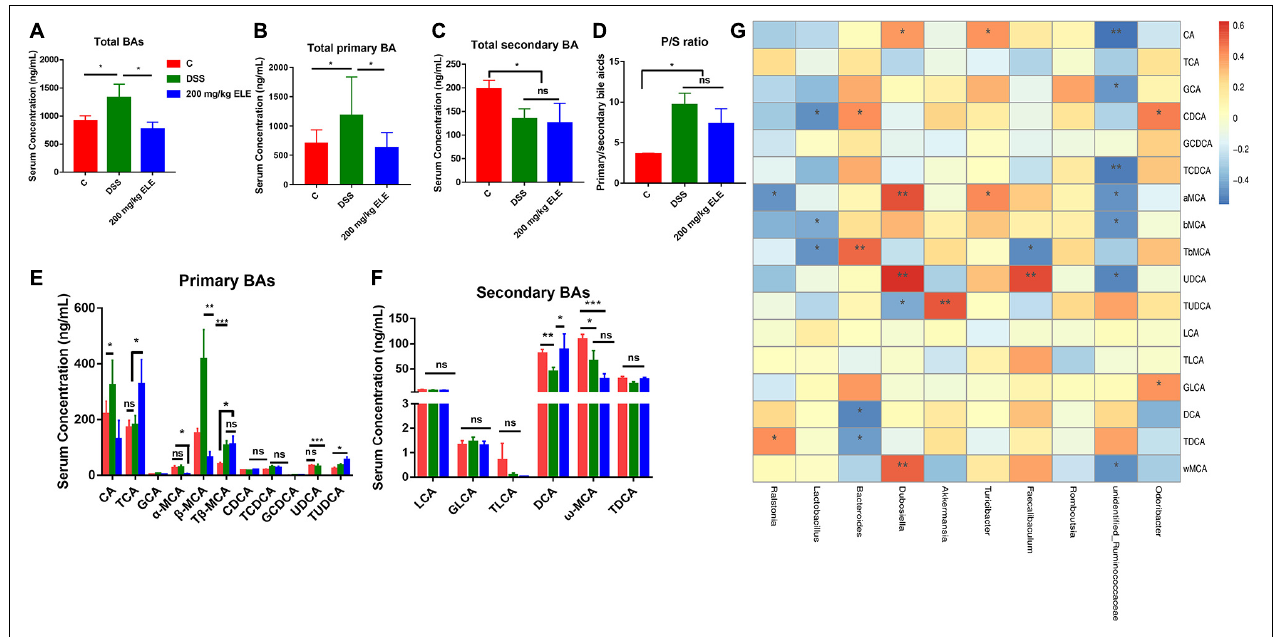
FIGURE 4 | Oral administration of ELE regulated the bile acids through gut microbiota regulatory effect in mice. (A) Content of total BA in serum. (B) The content of total primary BA in serum. (C) Content of total secondary BA in serum. (D) Ratio of primary bile acid to secondary bile acid content in serum. (E) Qualitative and quantitative analysis of primary bile acids. (F) Qualitative and quantitative analysis of secondary bile acids. (G) Correlation analysis of gut microbiota and bile acids. * p < 0.05; ** p < 0.01; *** p <